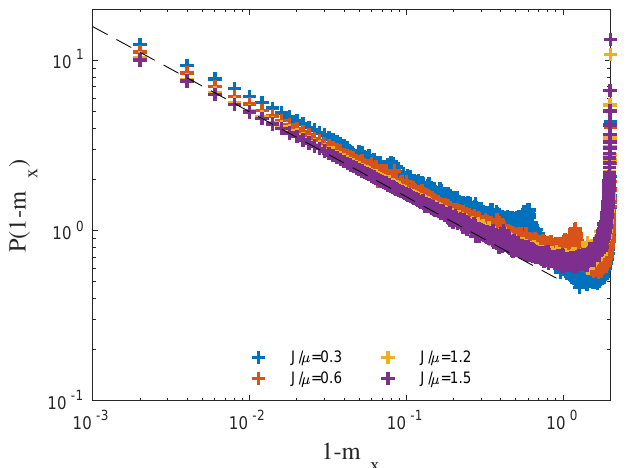
= 1 − S / S ≈ φ 2 , for the Lipkin- x x